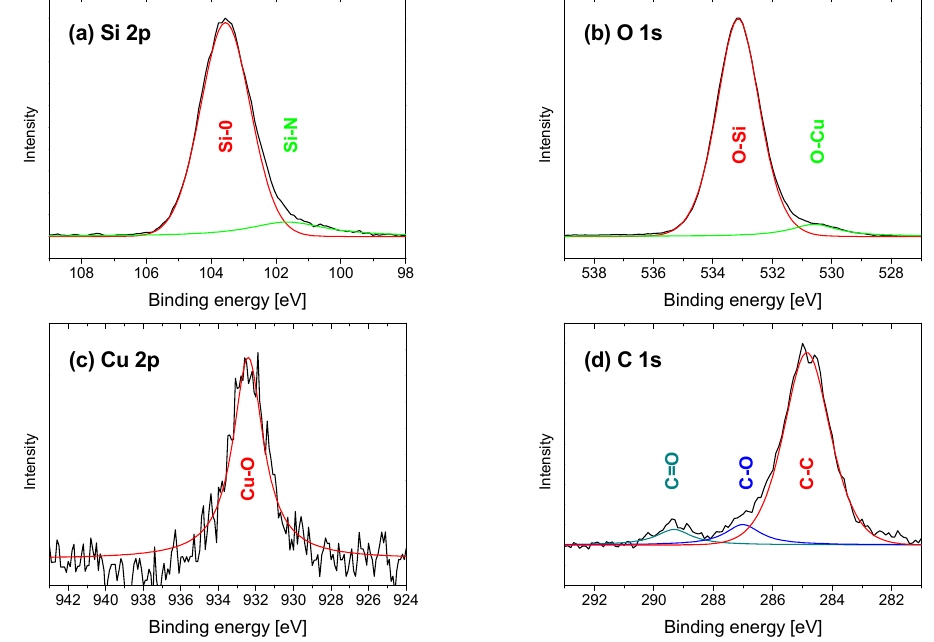
Figure 6. XPS spectra for the ( a ) Si 2p, ( b ) O 1s, ( c ) Cu 2p, and ( d ) C 1s orbitals of the Cu-SiO x film grown onto Si with a secondary precursor flow rate of 50 µl/min.